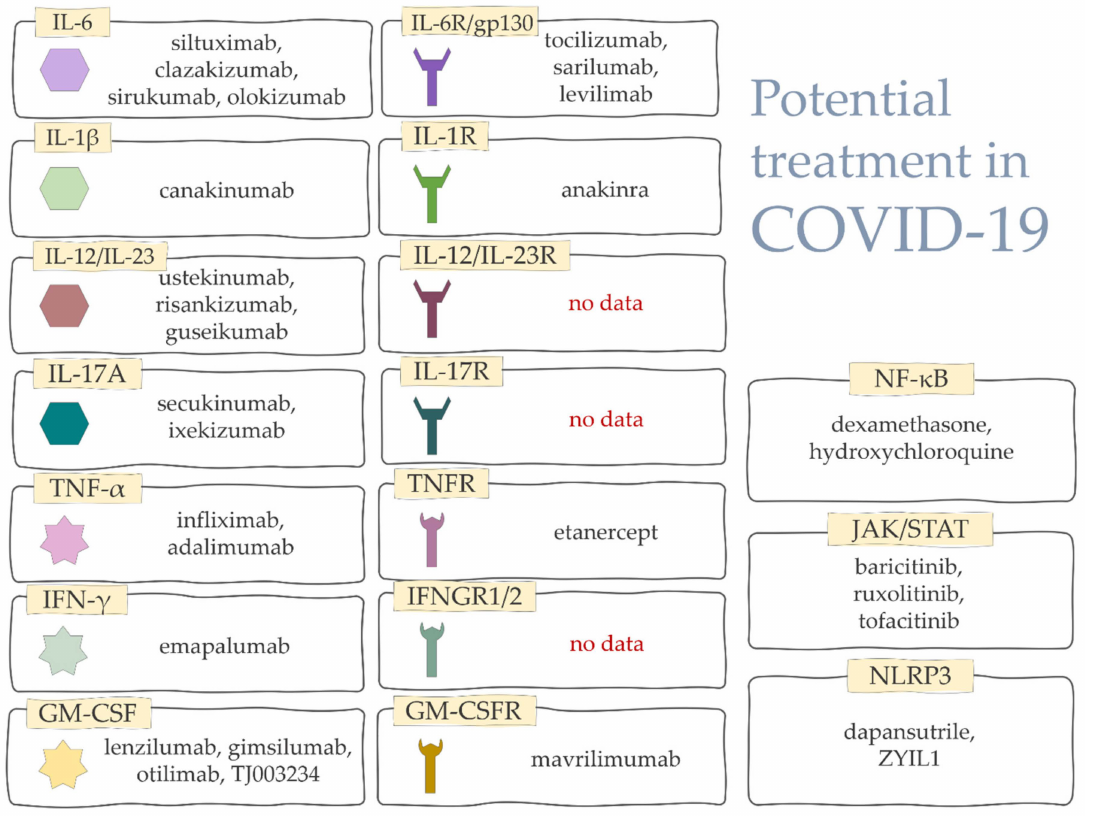
Figure 4. Main representatives of drugs used in